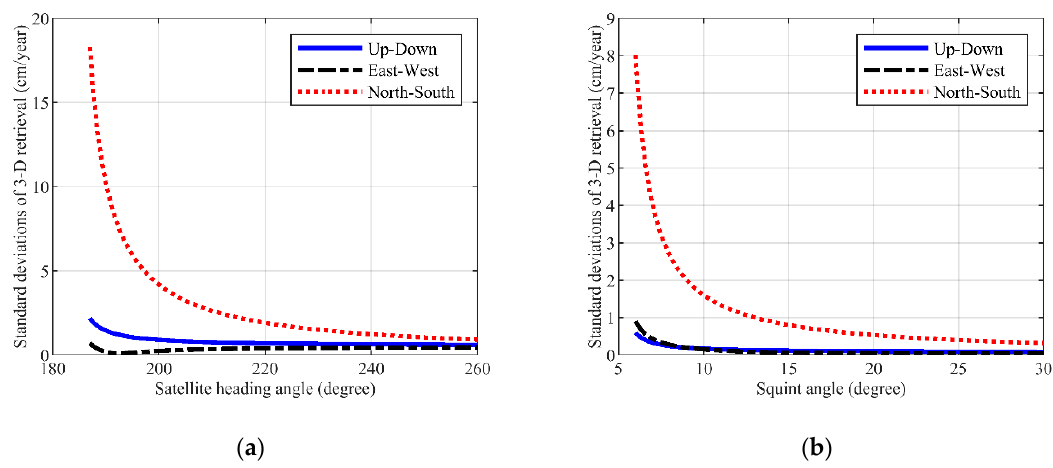
Figure 4. Impact of changing the satellite heading angle and using the acquisitions with different squint angles for the 3-D deformation retrieval. ( a ) and ( b ) are the diagrams of the standard deviations of 3-D retrieval varying with the satellite heading angle and squint angle, respectively.